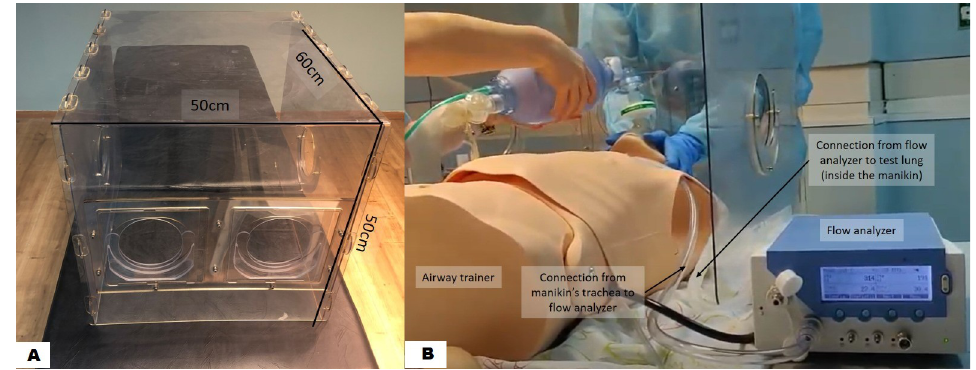
Fig 1. Study model. A. Study instrument, polycarbonate barrier box. B. Ventilation of the manikin using a two-person technique. The participant is holding the facemask while concurrently a study investigator is activating the Ambu 1 -